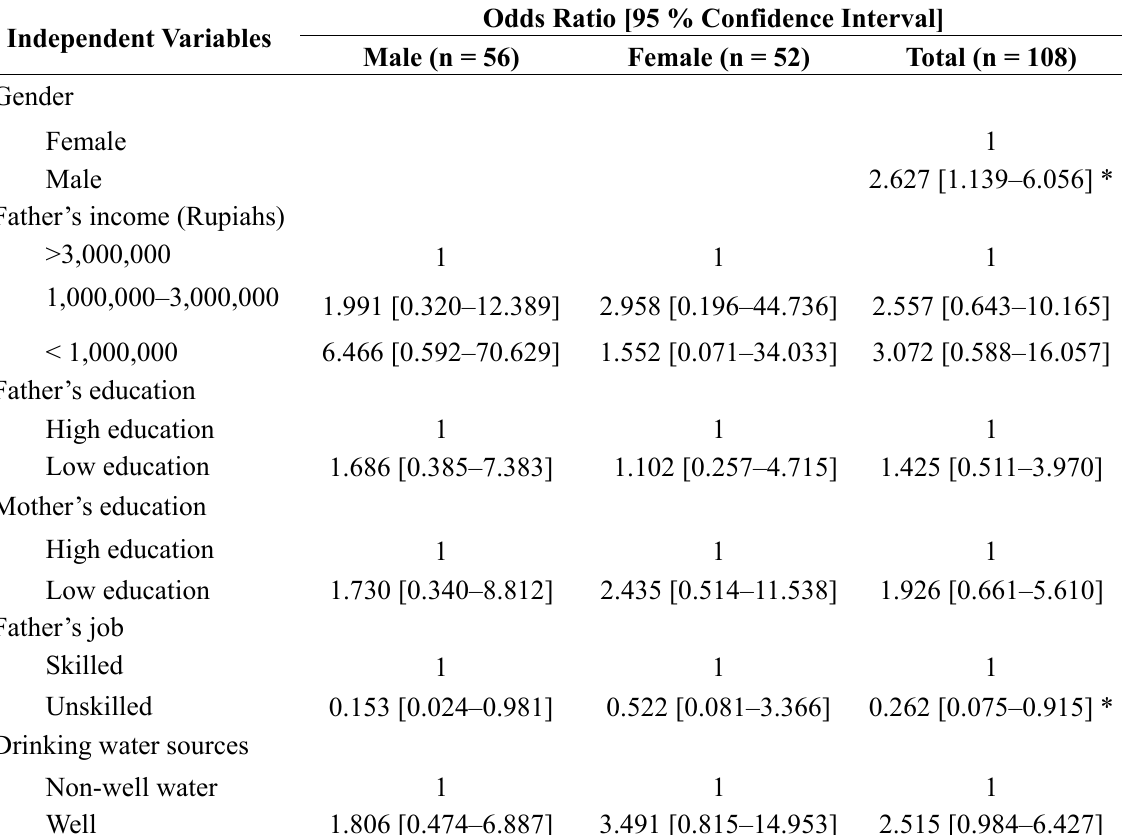
Table 3. Factors associated with increased BPb concentration among children in Serpong: Multivariate logistic regression